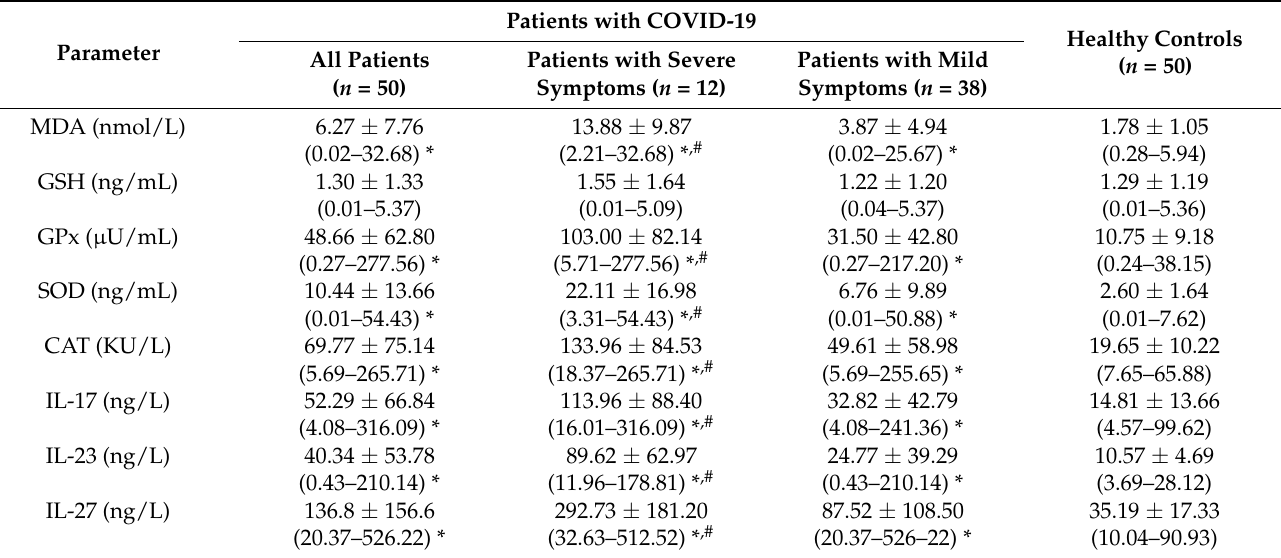
Table 4. Oxidative stress and immune parameters of the study